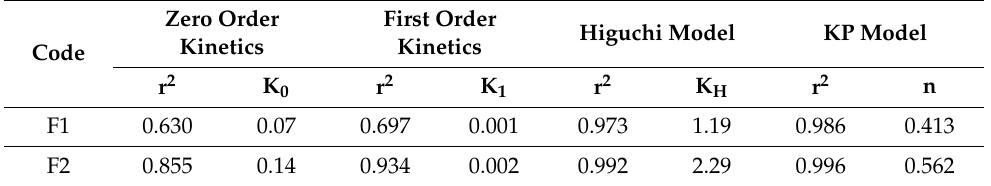
Table 3. Kinetic parameters for the ex vivo skin permeation of QT from formulations F1 and F4.